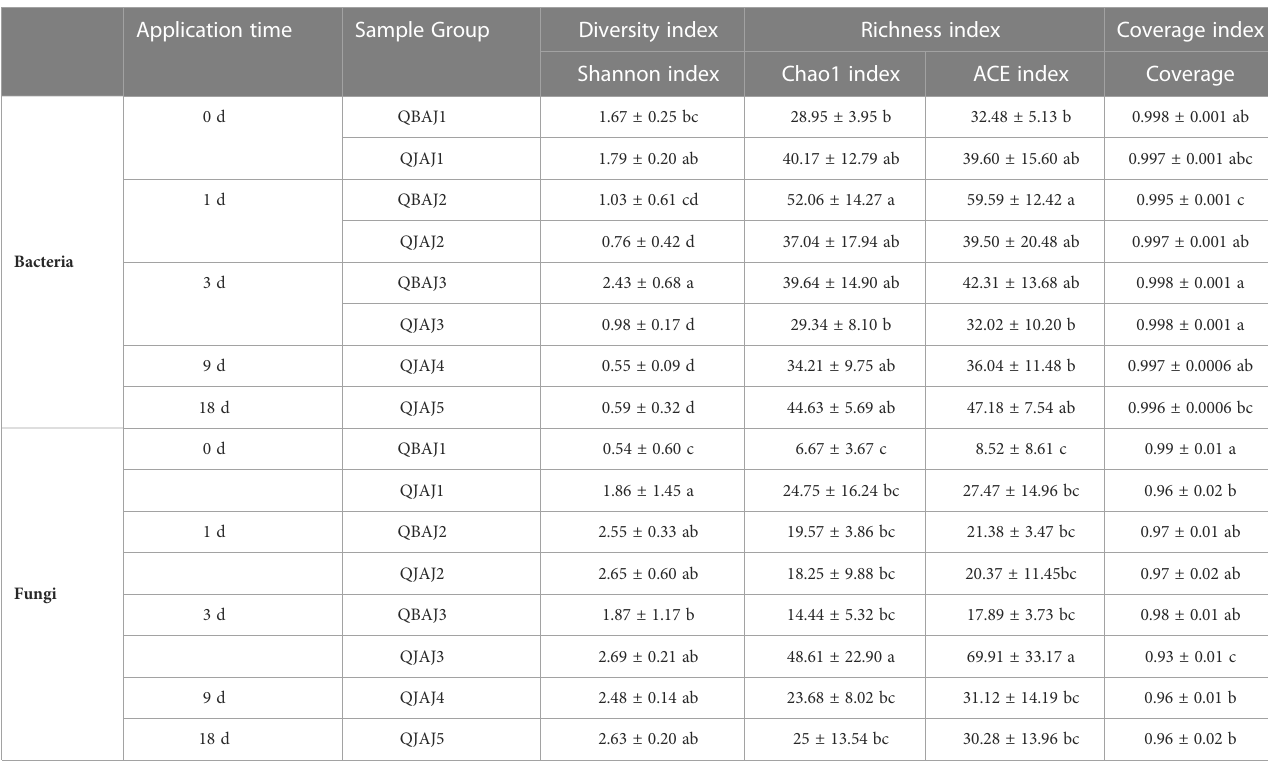
TABLE 4 Alpha-diversity and coverage indices of bacterial and fungal communities before and after application of azoxystrobin based on high- throughput sequencing. Application time Sample Group Diversity index Richness index Coverage index Shannon index Chao1 index ACE